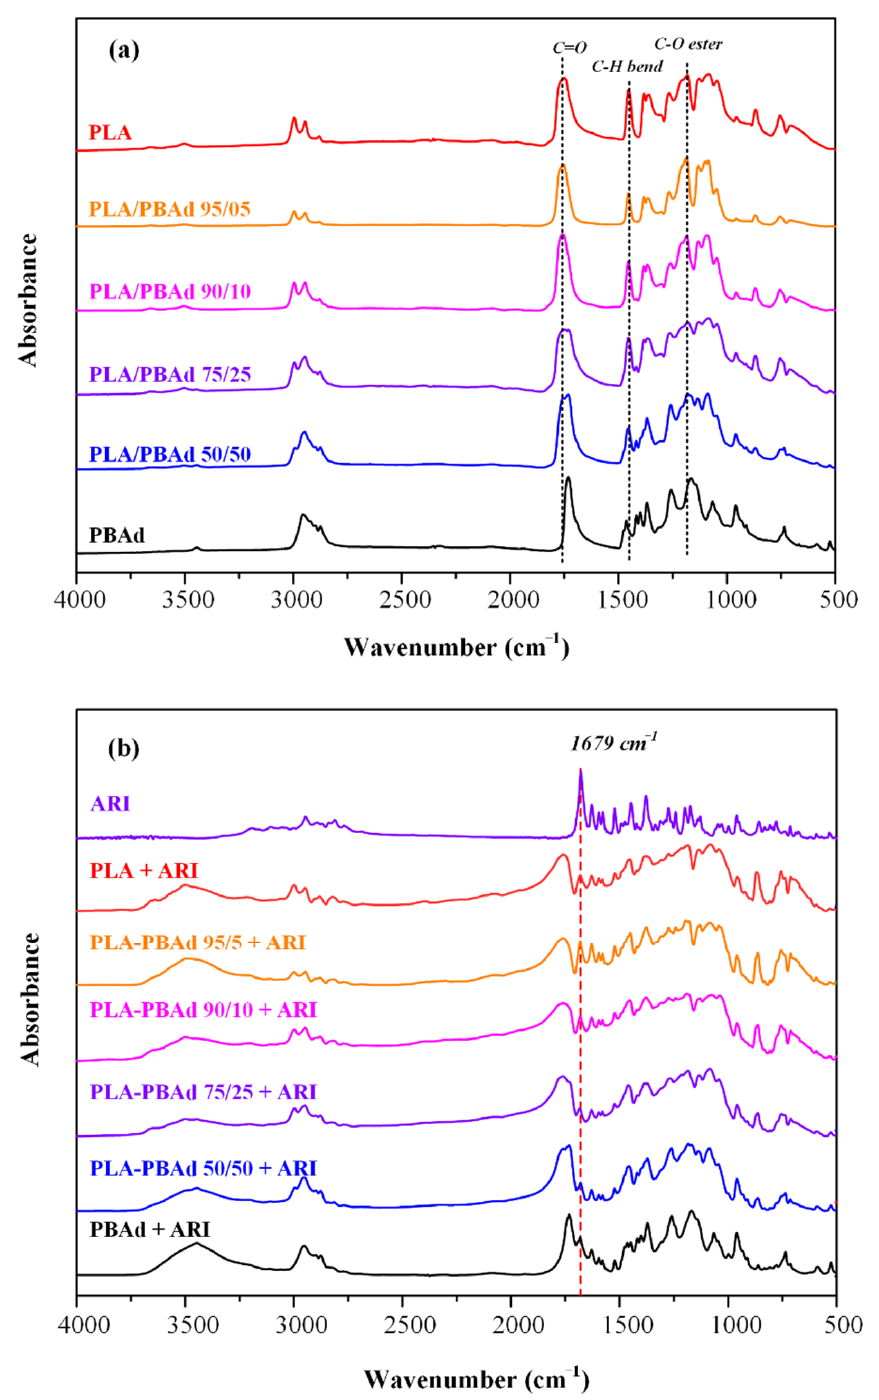
Figure 7. FTIR spectra of: ( a ) the neat PLA, PBAd and the PBA/PBAd copolymers and ( b ) the API and the prepared API-loaded MPs.